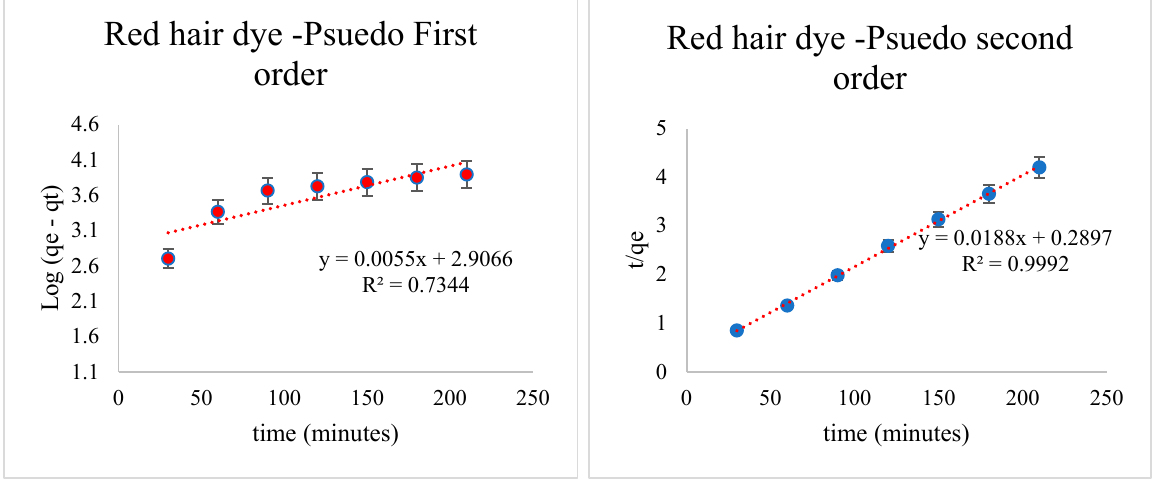
Figure 8. Kinetic studies of the adsorption of red hair dye onto COZ, [dosage = 0.07 g R, 0.06 g Y, & 0.05 E, C i = 50 mg·L − 1 , pH = 7.0, contact time = 120 min for R and E, 150 min for Y, T = 25 ± 1 °C, speed = 150 rpm].